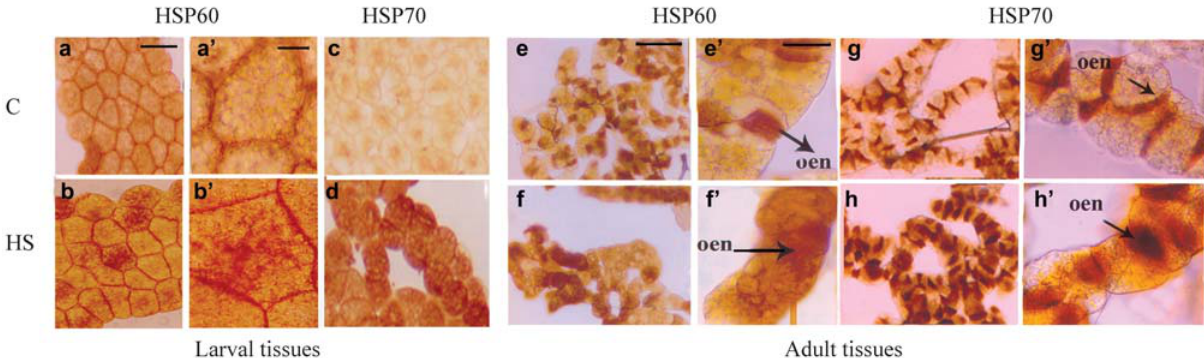
Figure 4A - Immunocytochemical staining of larval (FB, a-d) and adult (FB, e-h’) fat body tissues of M. domestica showing in situ expression of HSP60 (a,a’,b,b’,e,e’,f&f’)andHSP70(c,d,g,g’,h&h’)proteins.Figuresa,a’,e,e’,c,gandg’representthecontrol(C,25°C)andb,b’,d,f,f’,handh’the heatshocked(HS,42°C)tissues.Barrepresents100 μ minfiguresa,b,c,d,e,f,gandhand20 μ